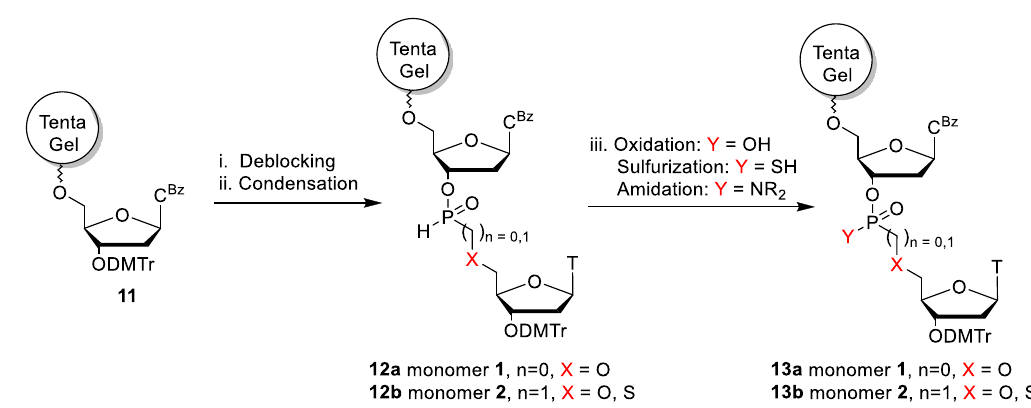
Scheme 1 . Model dimer for the optimization of H -phosphonate